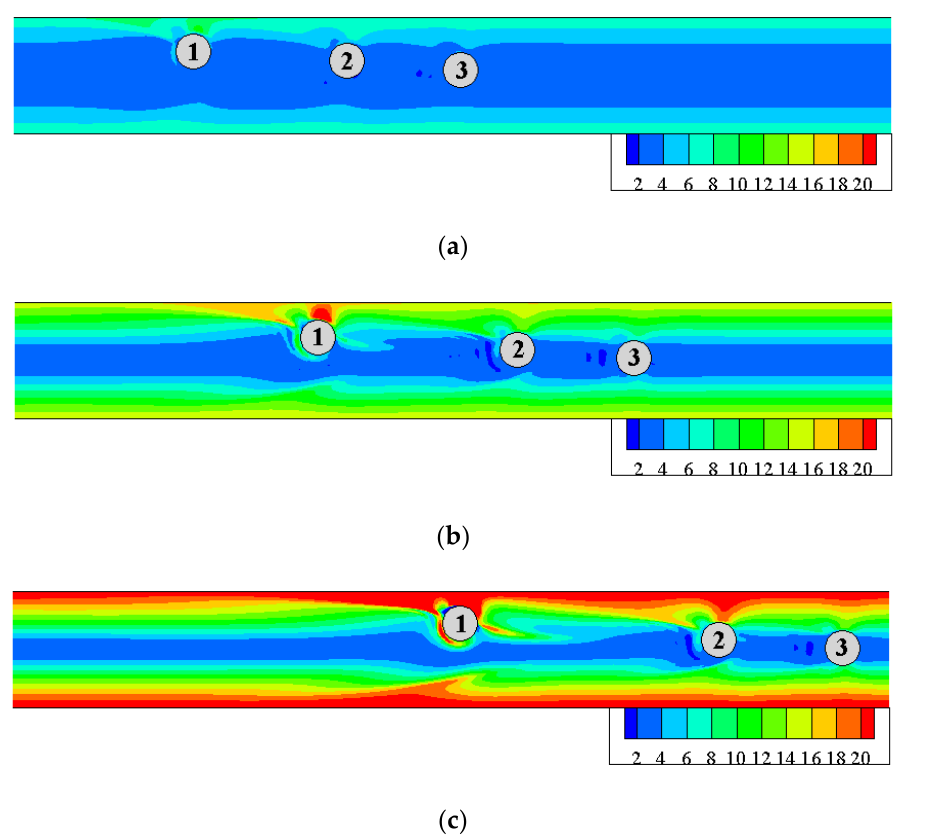
Figure 8. Polymer extension tr( B ) along the pathway in Giesekus fluid at t = 7 ( α = 0.1, η r = 0.3, ε = 0.3, y 0 = 0.2, d 1,0 = d 2,0 = 0.3). ( a ) Wi = 0.5; ( b ) Wi = 1.0; ( c ) Wi = 1.5.